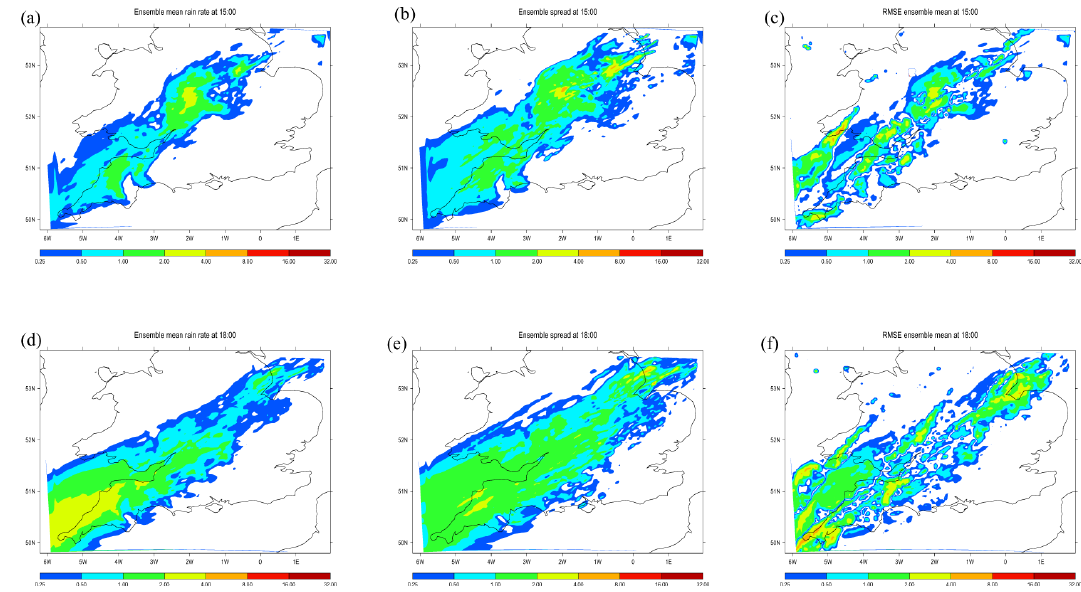
Fig. 9. Spatial distribution of rain rate diagnostics (mmh − 1 ) for the control ensemble. Left column: ensemble mean, middle column: ensem- ble spread and right column: innovation magnitude of the ensemble mean, at 15:00UTC (top row) and 18:00UTC (bottom row) 20 Septem- ber